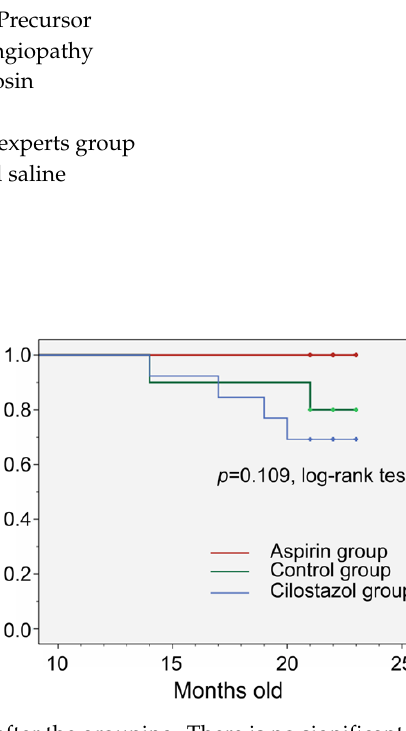
Figure A1. The survival rates after the grouping. There is no significant difference in the survival rate after the grouping among the three groups (control group, 80%; aspirin group, 100%; cilostazol group, 69% ( p = 0.109, log-rank test: 14 mice evaluated for the first specimen are excluded from the analyses). Even in the two group comparisons, no differences are seen in the survival rate between the control group and the aspirin or cilostazol group ( p = 0.098 and p = 0.550, log-rank test).